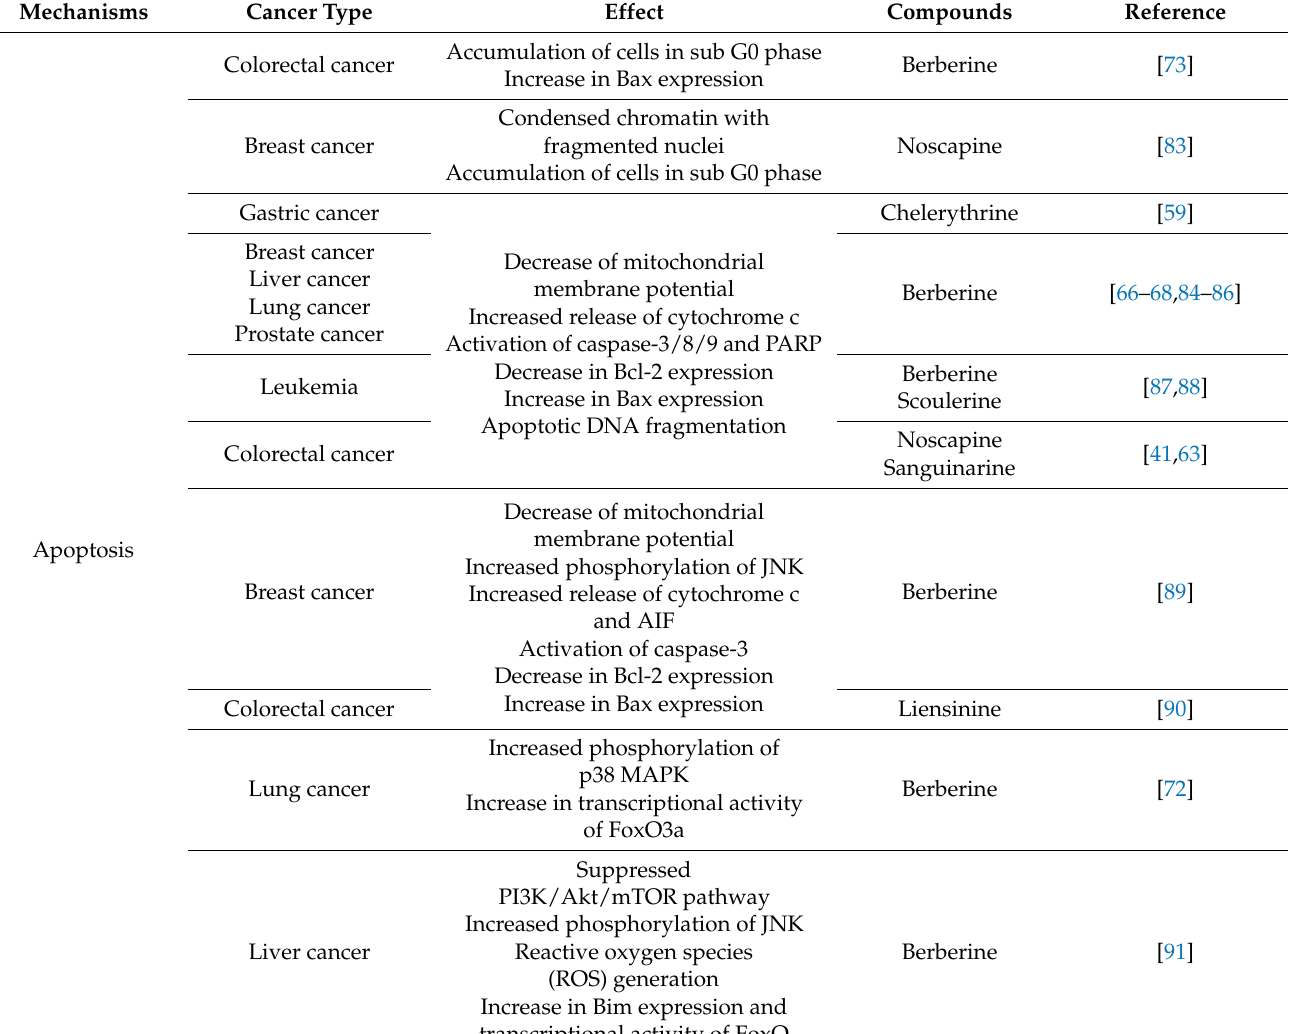
Table 1. Current evidence on anticancer effects of isoquinoline